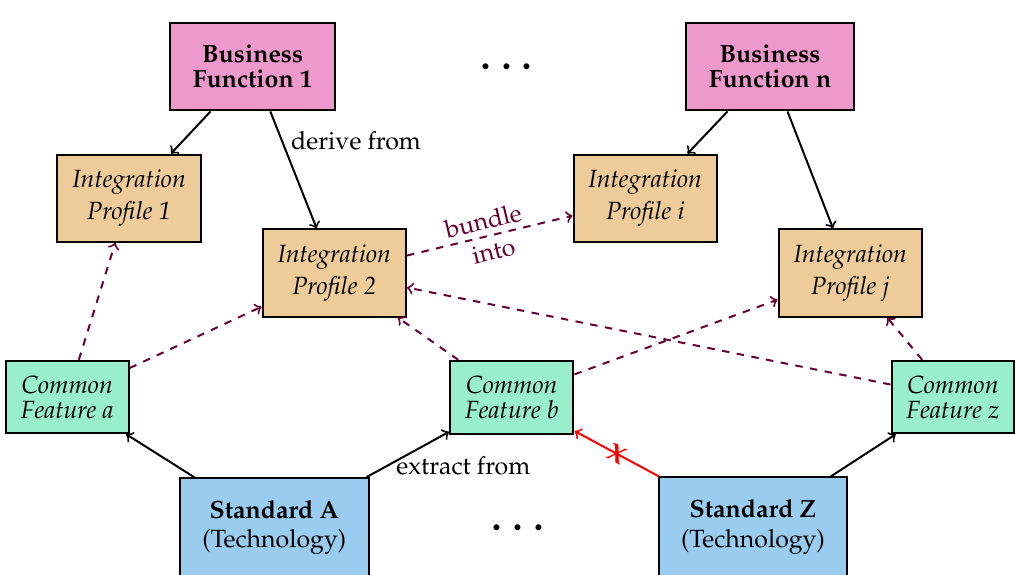
Figure 14. Common Features: bundling highly flexible features as provided by modern